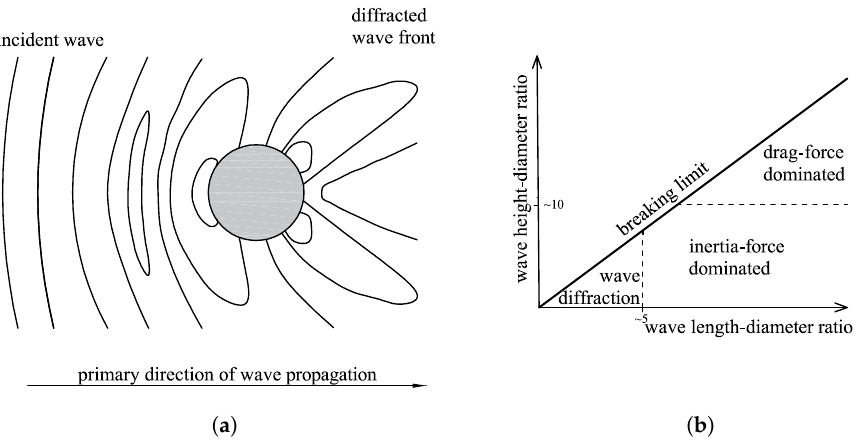
Figure 12. ( a ) Schematic representation of the diffracted wave field around a cylindrical structure [87], and ( b ) the governing hydrodynamic force on a cylindrical structure as a function of the wave length-diameter and wave height-diameter